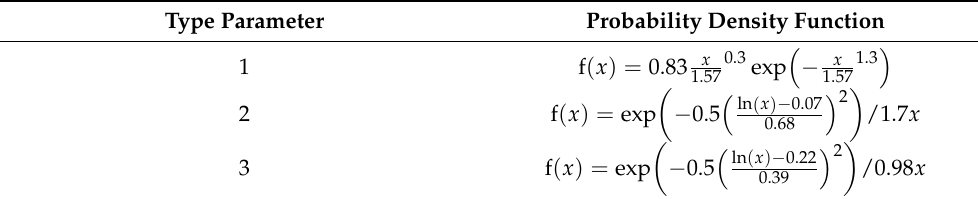
Table 2. Probability density function of passenger service time depending on the TYPE parameter.